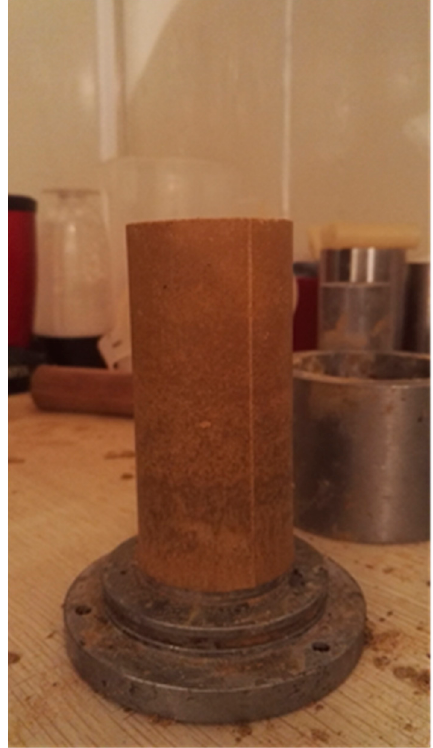
Figure 6. Samples of CH 4 hydrate-bearing sediments.